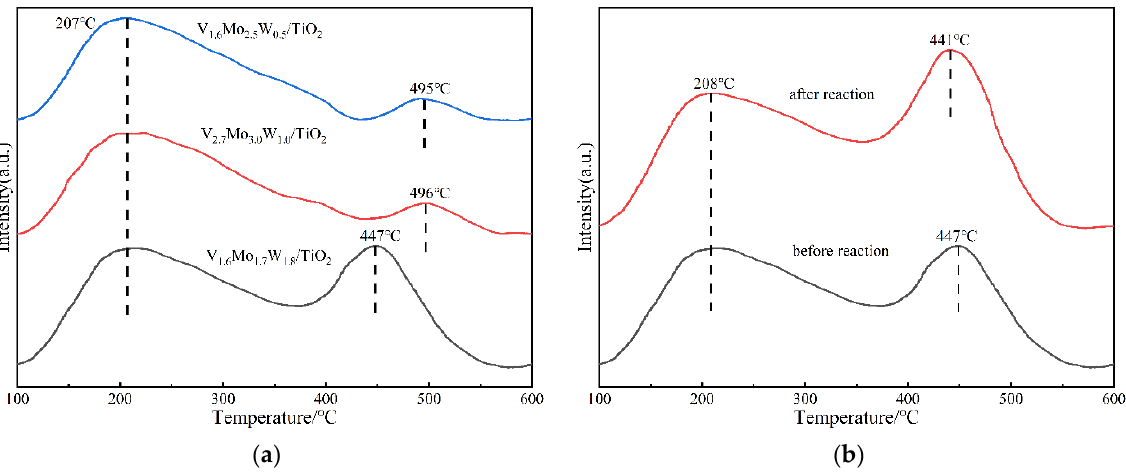
Figure 11. NH 3 -TPD of the three catalysts: ( a ) the three fresh catalysts and ( b ) V 1.6 Mo 1.7 W 1.8 /TiO 2 before and after reaction.